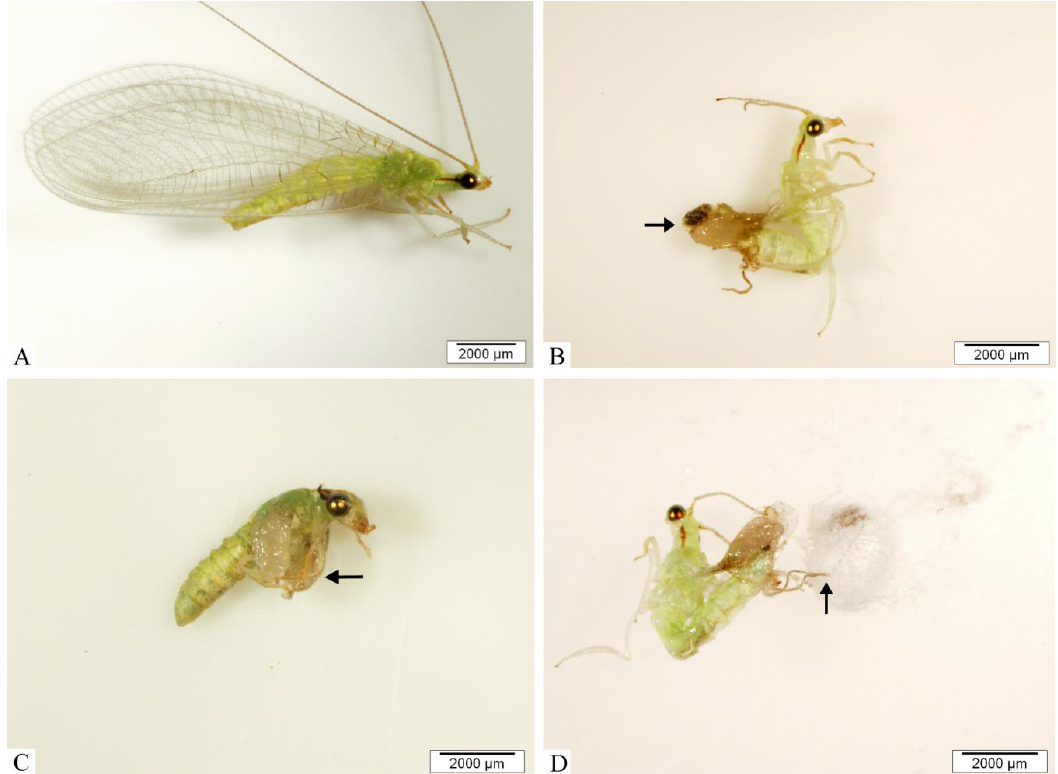
Figure 2. Macroscopic damage to adults of C. claveri after treatment with C. nardus oil. No deformity was observed in C. claveri adults (control group) ( A ), emergence and incomplete development following treatment with C. nardus (1 µg/mL, ( B ); 10 µg/mL, C and 100 µg/mL, ( D )). ( C ) Note the non-formation and incomplete distension of the wings and antennae ( arrow ). ( D ) Note the inability of the adult to emerge from the cocoon ( arrow ). Photographs were taken with an Olympus SZX16 stereo microscope with Cell D Imaging Software (Olympus Soft Imaging Solutions GmBH, Münster, Germany). Table 3. The effects of exposure to C. nardus EO on viability (%) during the formation of C. claveri adults. Treatment ( µ